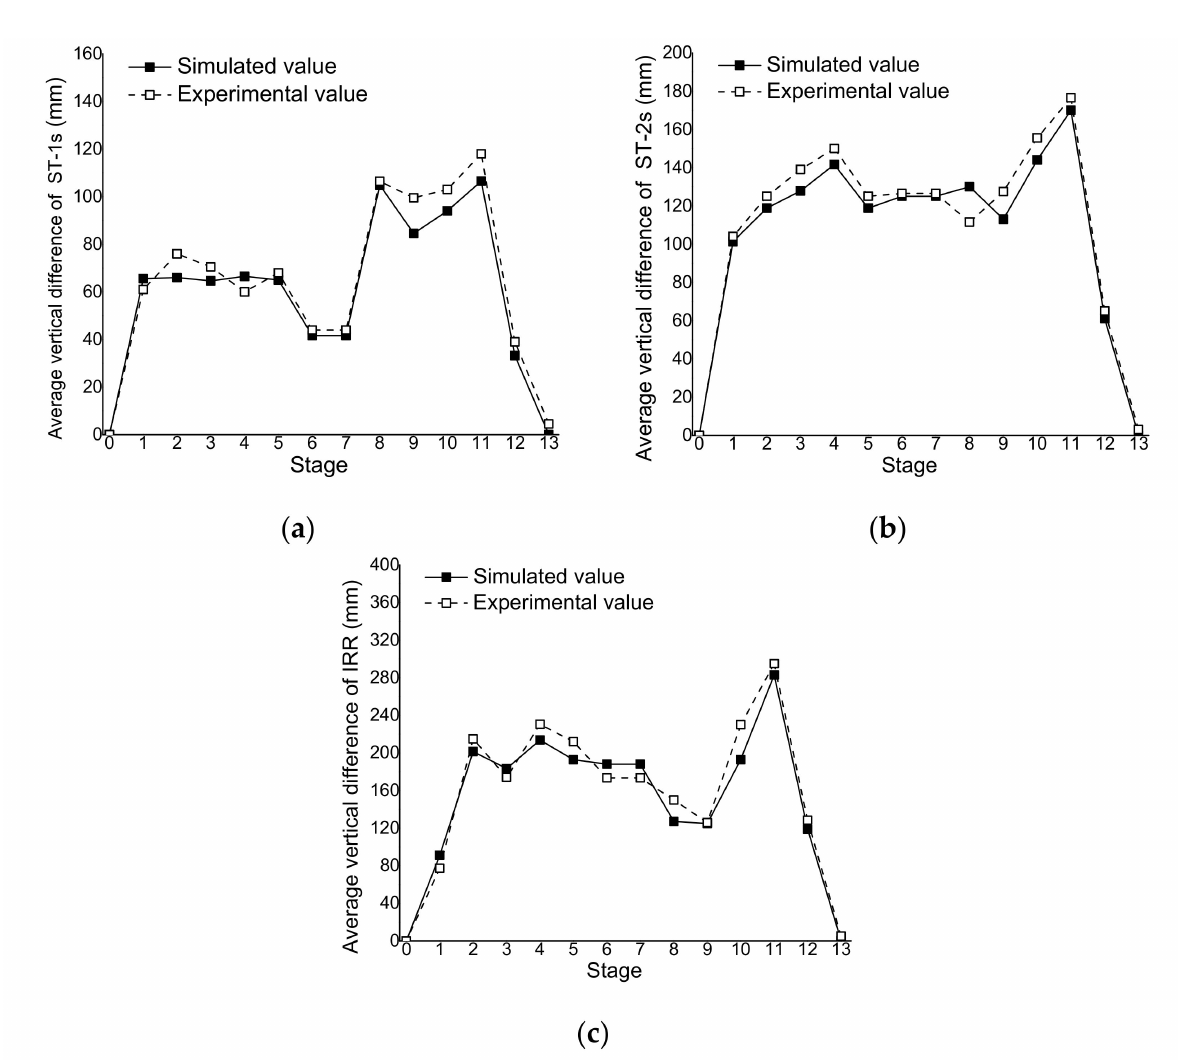
Figure 17. Average vertical difference of the top nodes of ST-1, ST-2, and IRR. ( a ) ST-1; ( b ) ST-2; ( c ) IRR.